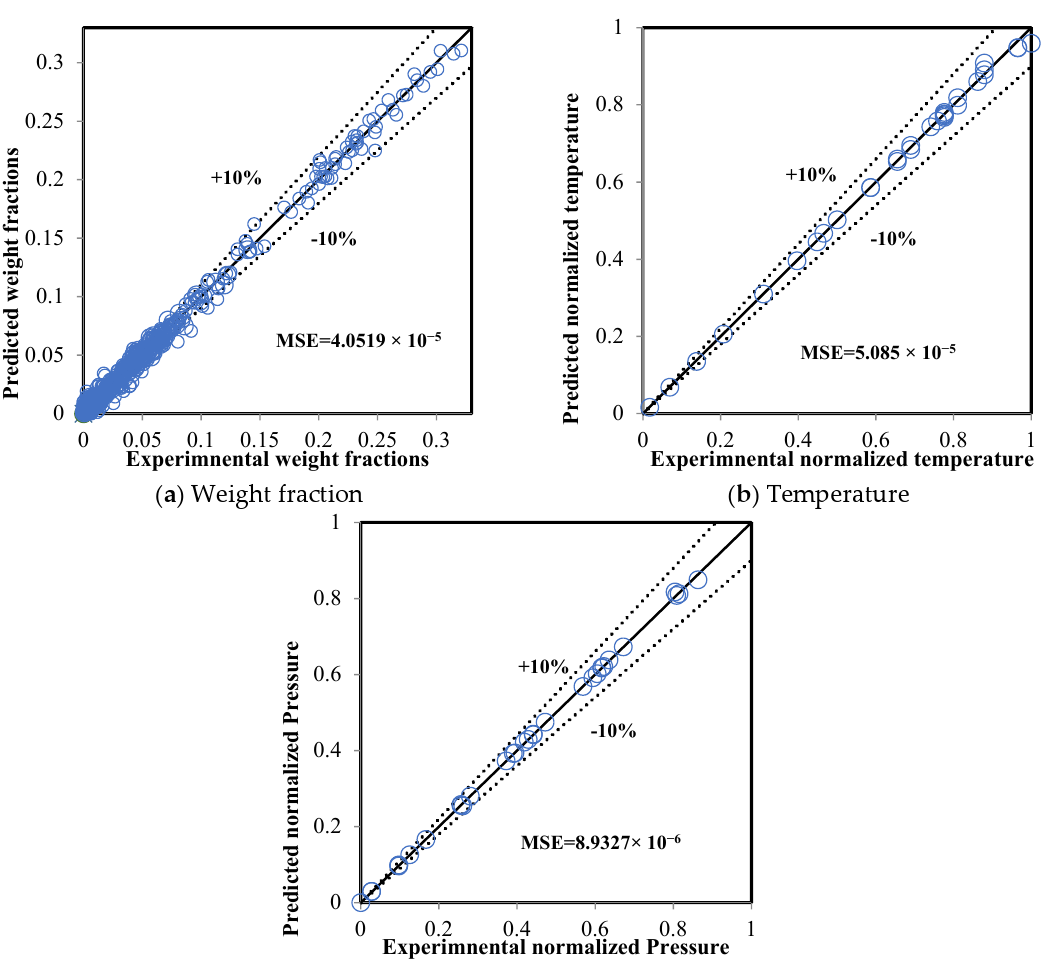
Figure 5. Comparison between the actual and ANN results (training mode).